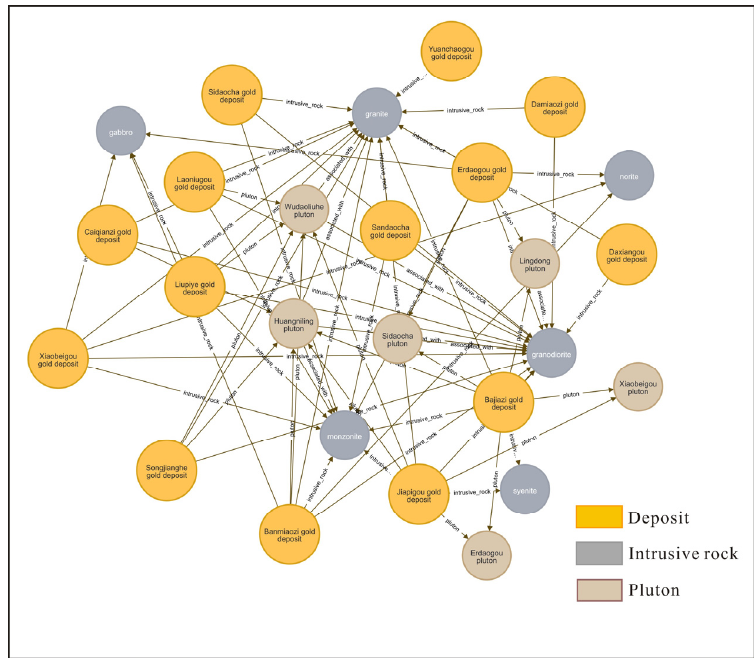
Figure 8. A subgraph for the plutons, intrusive rocks, and ore deposits.